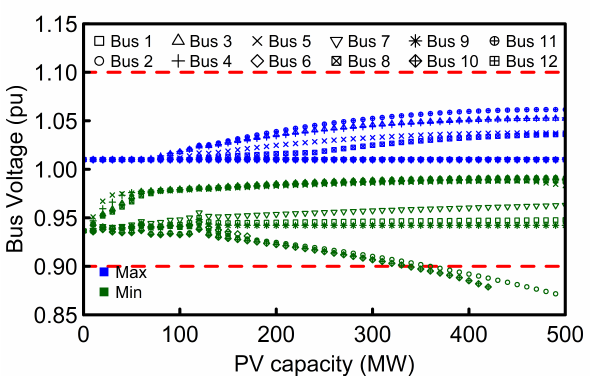
Figure 13. The maximum and minimum bus voltage variation for increasing PV capacity over multiple points of interconnection (POI). A PV capacity is undesirable if it leads to bus voltage variation above 1.1 or below 0.9 pu.